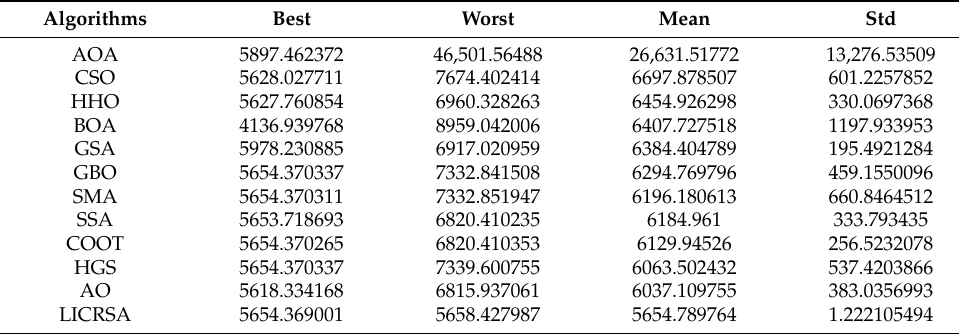
Table 11. Statistics of 20 independent operations of pressure